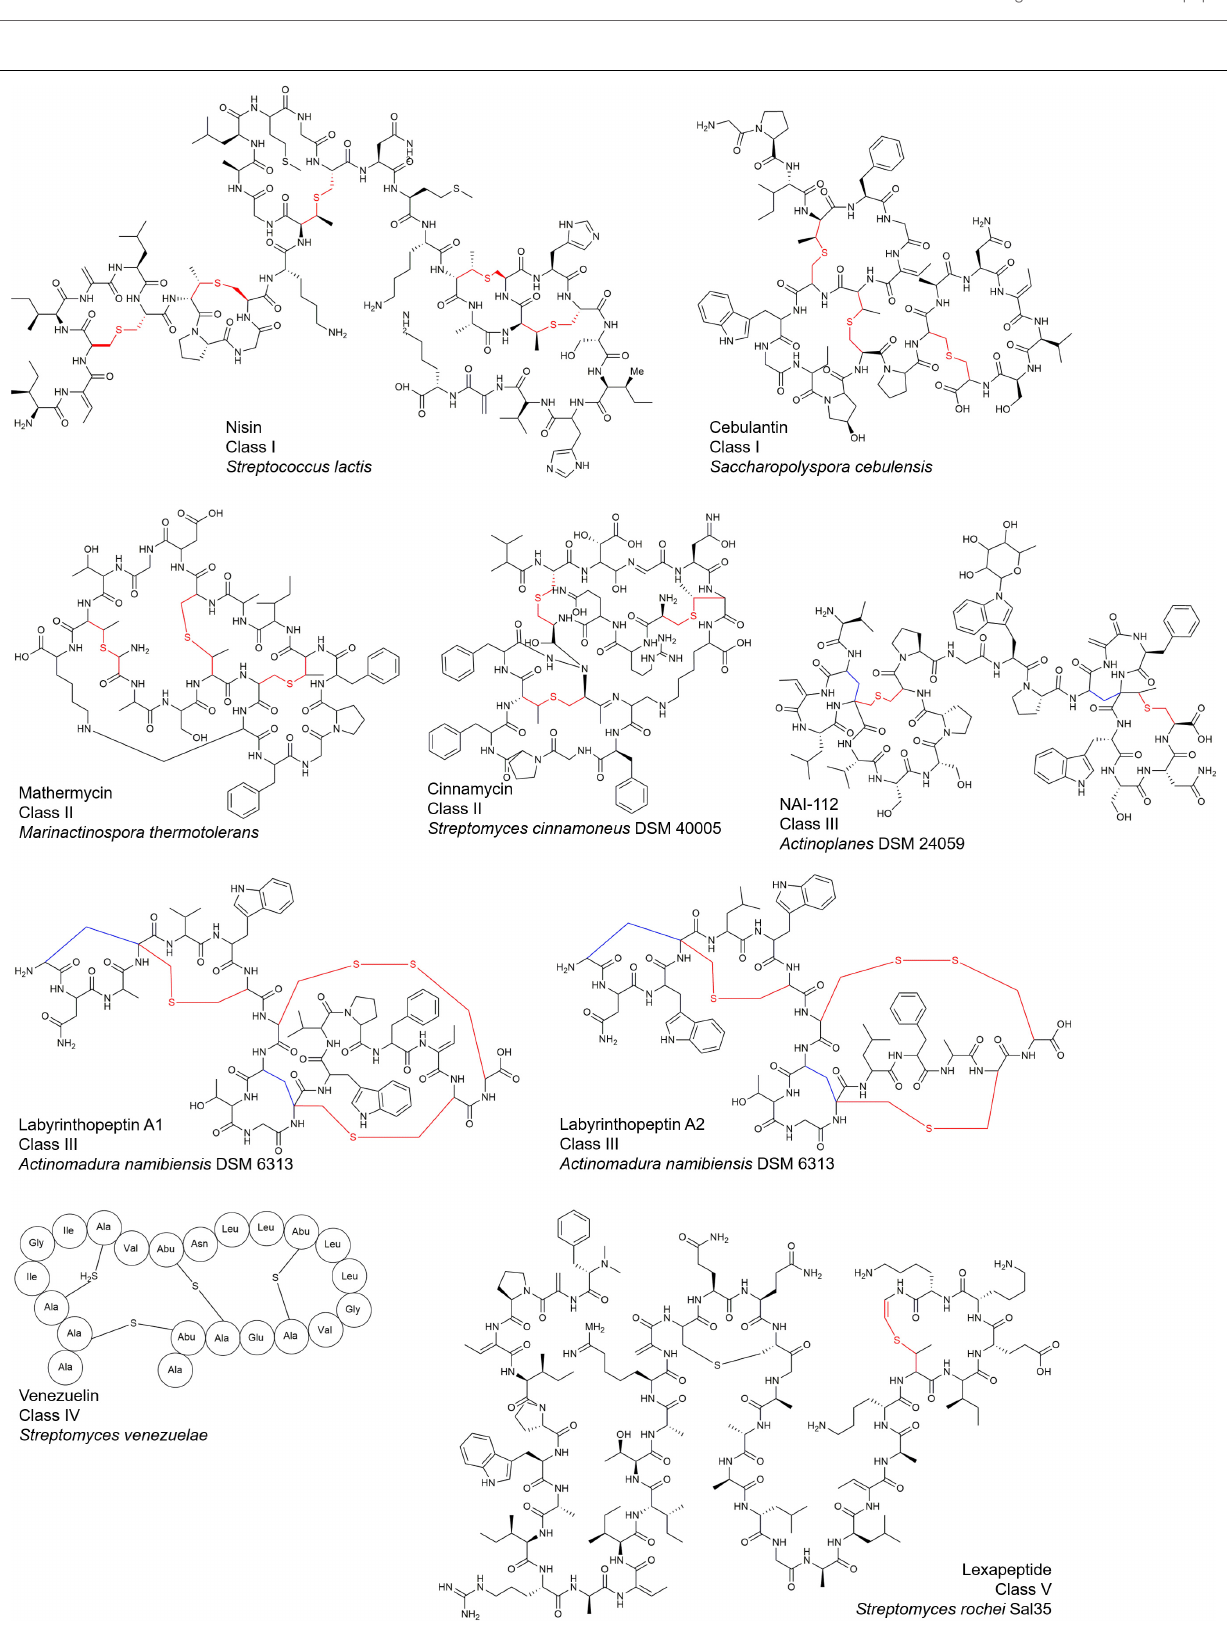
FIGURE 1 | Structures of representative lanthipeptides.